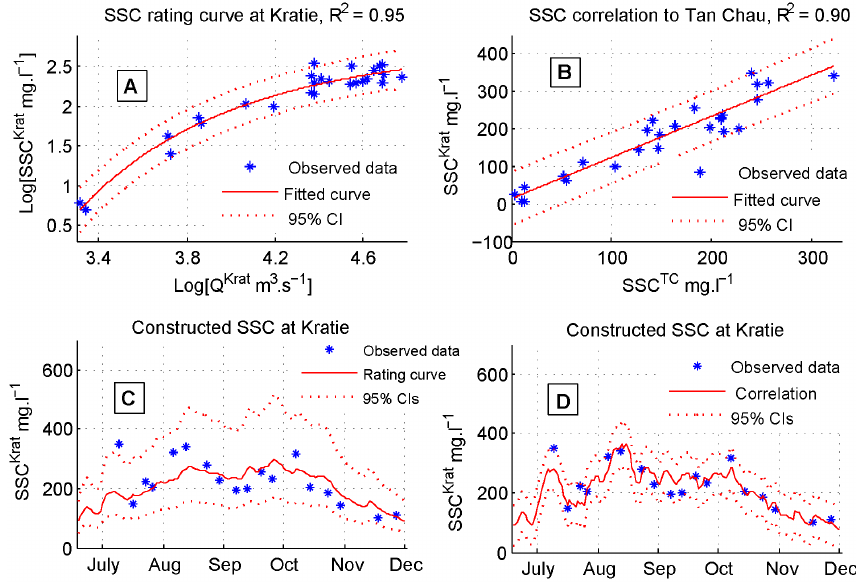
Figure 4. (a) Derived SSC for Kratie using sediment rating curve, (b) derived SSC for Kratie using correlation to SSC at Tan Chau, (c) comparison of sediment rating curve method with measured data in 2011, (d) comparison of correlation method with measured data in